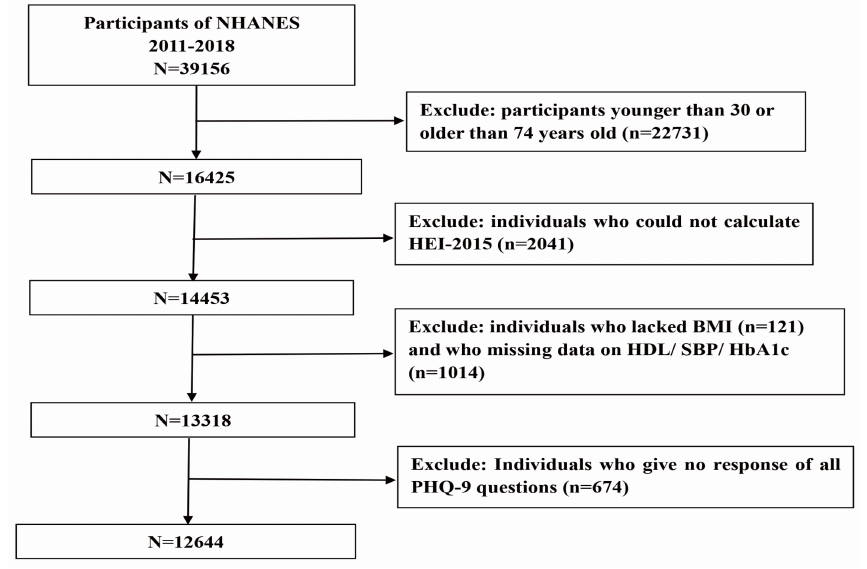
Figure 1. Flow chart of the screening process for the selection of eligible